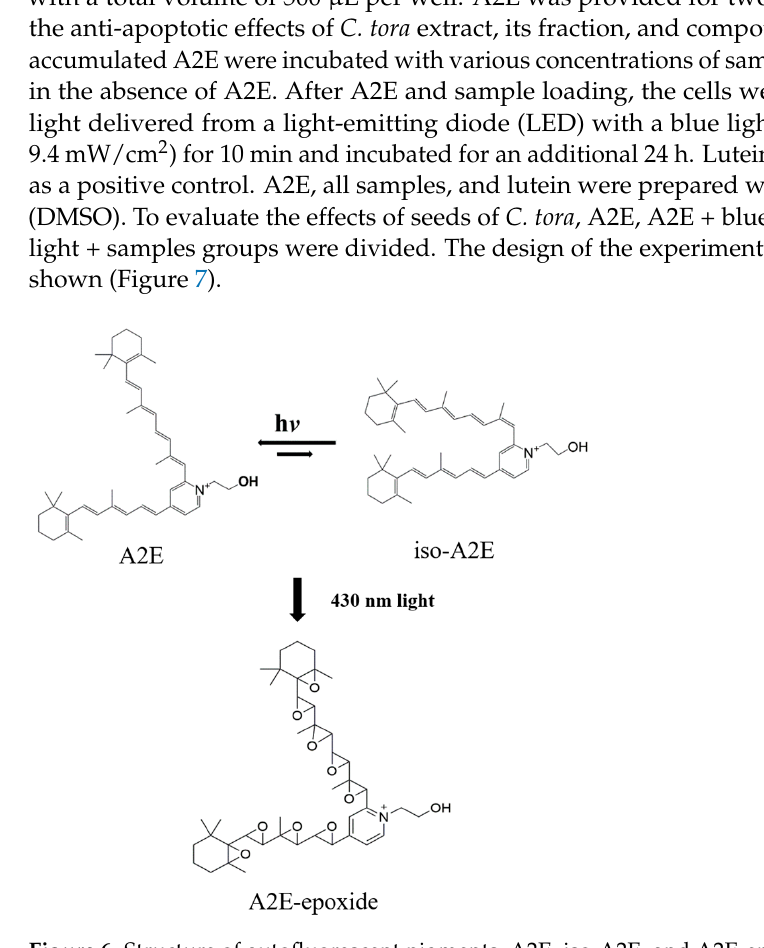
Figure 6. Structure of autofluorescent pigments, A2E, iso-A2E, and A2E-epoxide.